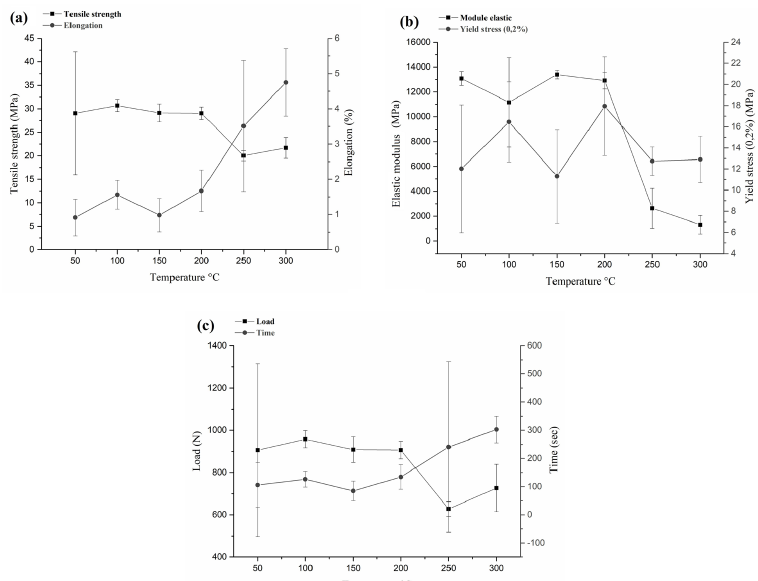
Figure 4. Relationship between tensile properties and annealing temperature: (a) Tensile strength and elongation, (b) elastic modulus and yield stress, and (c) load and rupture time of AA 5182 Alloy heated to 50 °C, 100 °C, 150 °C, 200 °C, 250 °C and 300 °C for10 min.